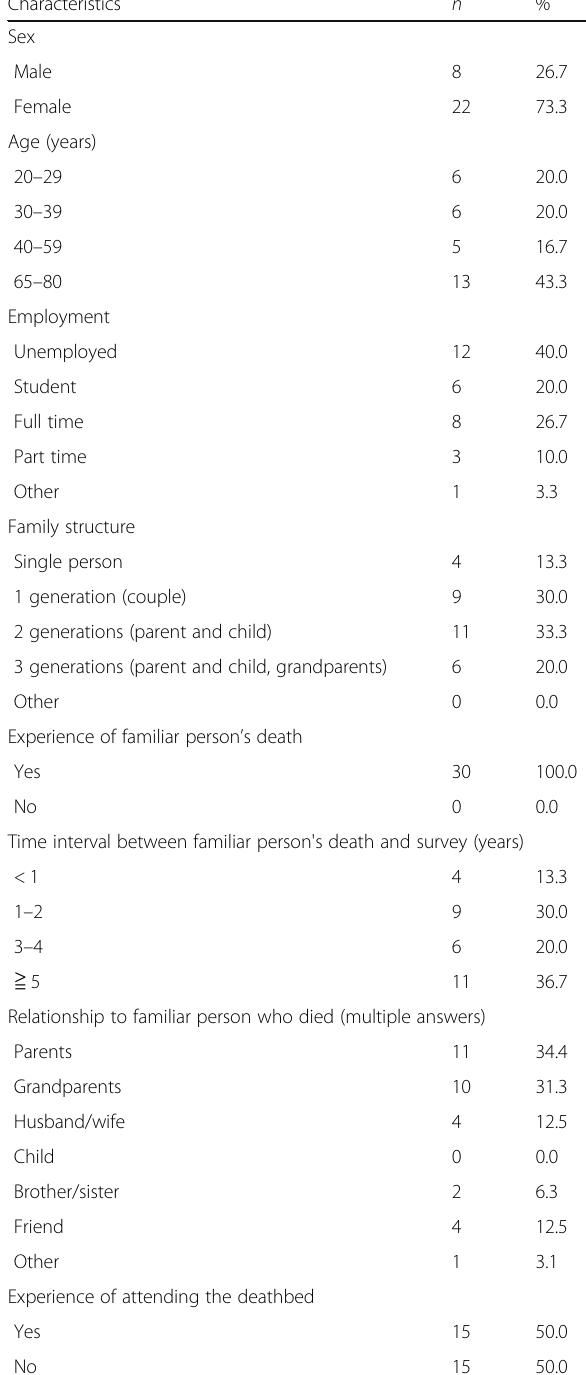
Table 2 Baseline characteristics of the study participants